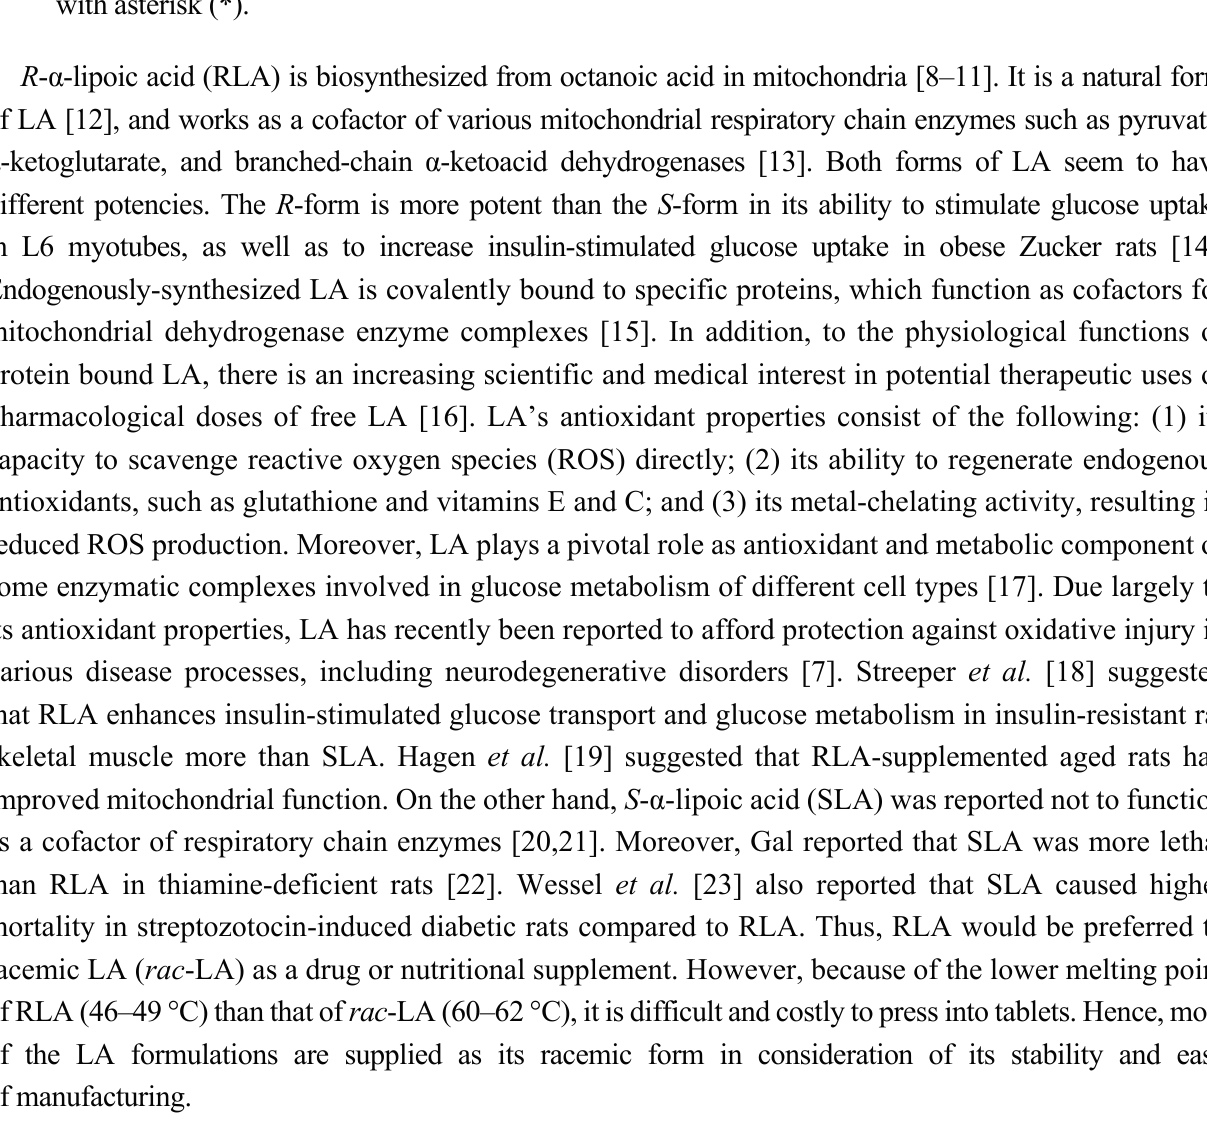
Figure 1. Structure of R - α -lipoic acid ( A ) and S - α -lipoic acid ( B ). Chiral center shown with asterisk